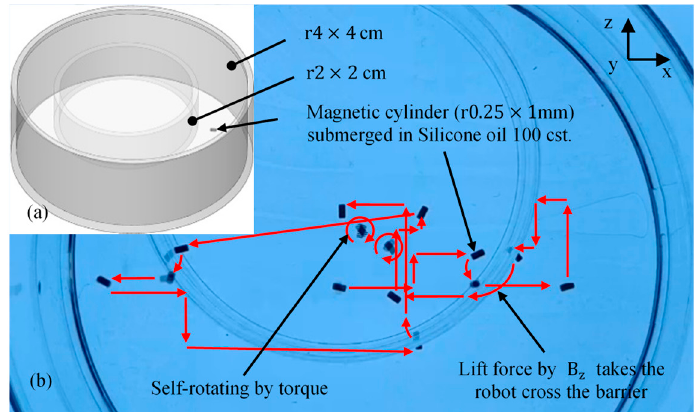
Figure 9. Translation locomotion by gradient based field. ( a ) the double-layer cylinder containing 100-cst.-silicone Oil. ( b ) a micro-cylindrical robot is manipulated by both force and torque to move in the arena. Red arrows represent the moving path of the robot.